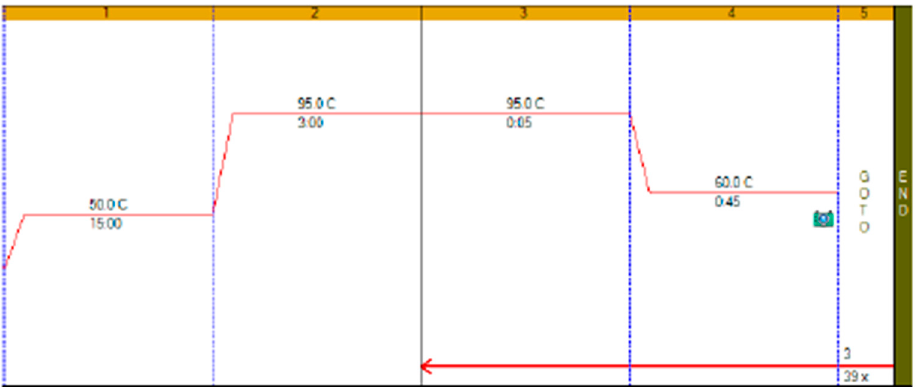
Figure 1. Thermal profile of a typical RT-qPCR test run on a BioRad CFX qPCR instrument. Here, the